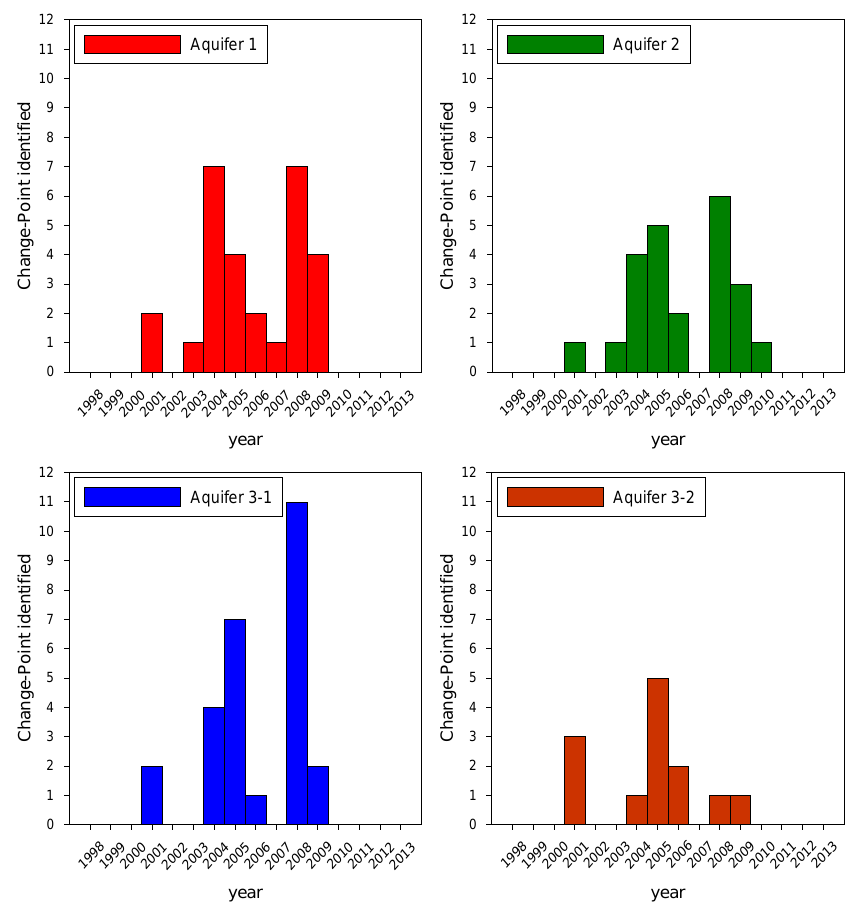
Figure 6. Histograms of identified change points for each aquifer, representing frequency distributions of identified years when groundwater level series at any gauges experience a shift in the